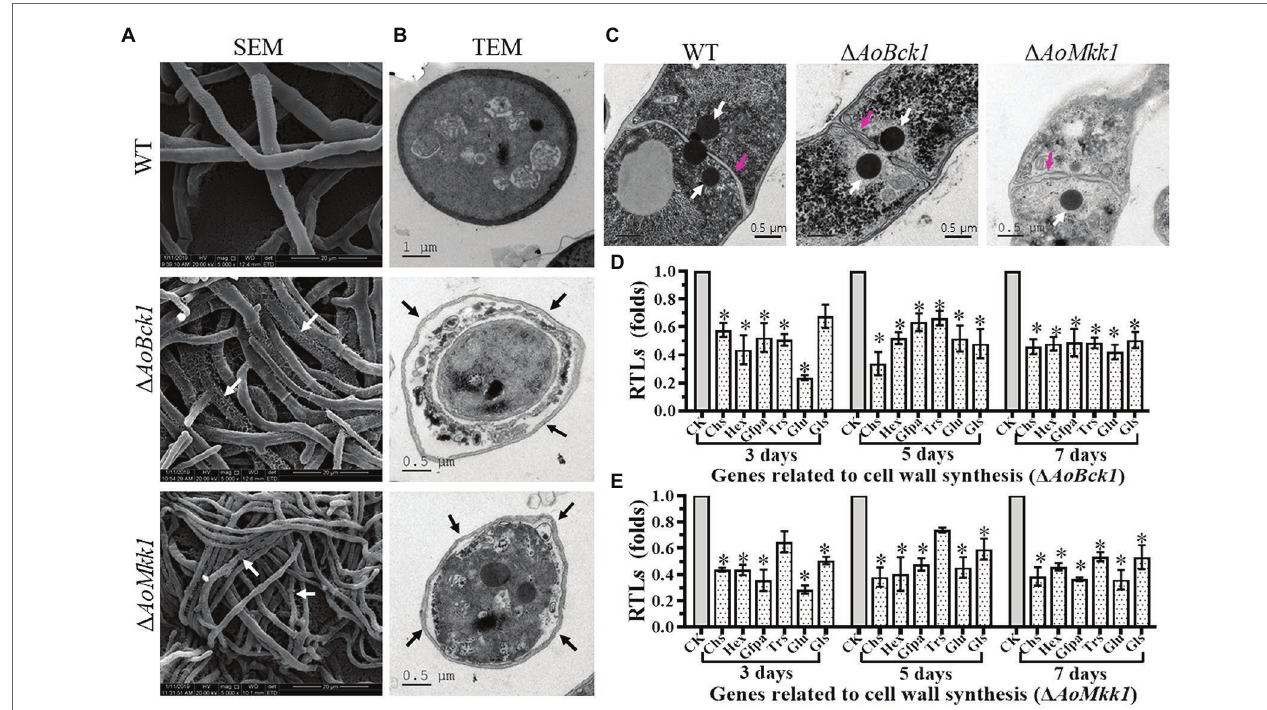
FIGURE 4 | Observation of mycelial morphology using scanning electron microscopy (SEM) and transmission electron microscope (TEM), and transcript of genes associated with cell wall biosynthesis in the WT and mutants. (A) Mycelia of each strain were examined using SEM. Bar = 20 μ m. White arrows: the fragmented mycelial surface; (B) Observation of hyphal cells by TEM. Bar = 1 μ m (WT) or 0.5 μ m (mutants). Black arrow: separation of cell wall and cell membrane. (C) Comparison of Woronin bodies between the WT and mutants. The hyphae of each strain cultured at 28 ° C in PD broth for 18 h, after which, post fixing in 2.5% glutaraldehyde, samples were examined by TEM. Red arrow: hyphal septum; white arrows: Woronin body. Bar = 0.5 μ m. (D) RTLs of selected genes involved in cell wall synthesis of the WT and Δ AoBck1 mutant at different time points. (E) RTLs of selected genes involved in cell wall synthesis of the WT and Δ AoMkk1 mutant at different time points. CK under given conditions, using CK with an RTL of 1 as the standard, statistical analysis was performed on the RTL of each gene in each mutant and the WT strain. An asterisk indicates a significant difference compared to the WT ( p <